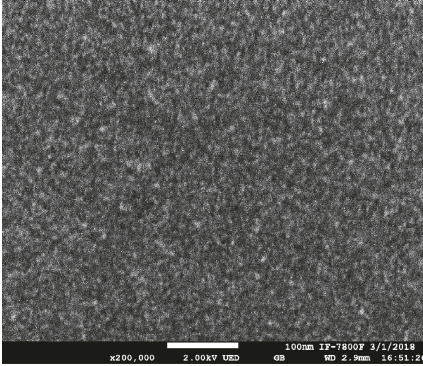
Figure 5: FE-SEM image of the TiO 2b blocking